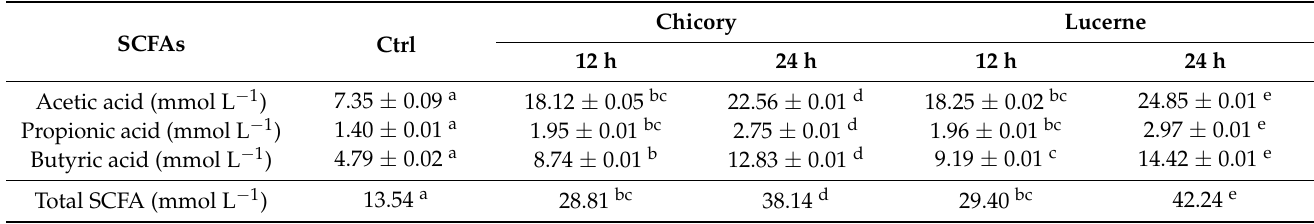
Table 5. Production of short-chain fatty acids during cecal fermentation of chicory and lucerne. SCFAs